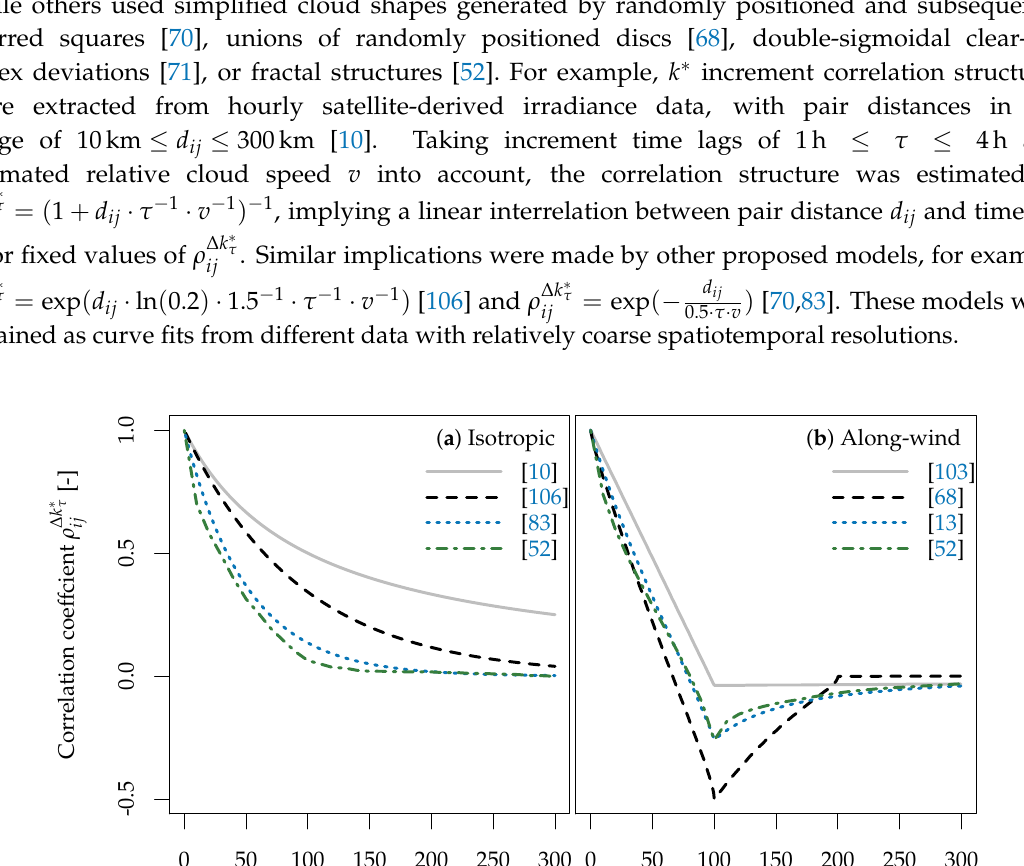
Figure 7 contrasts estimated clear-sky index increment correlation structures ρ ∆ k ∗ τ